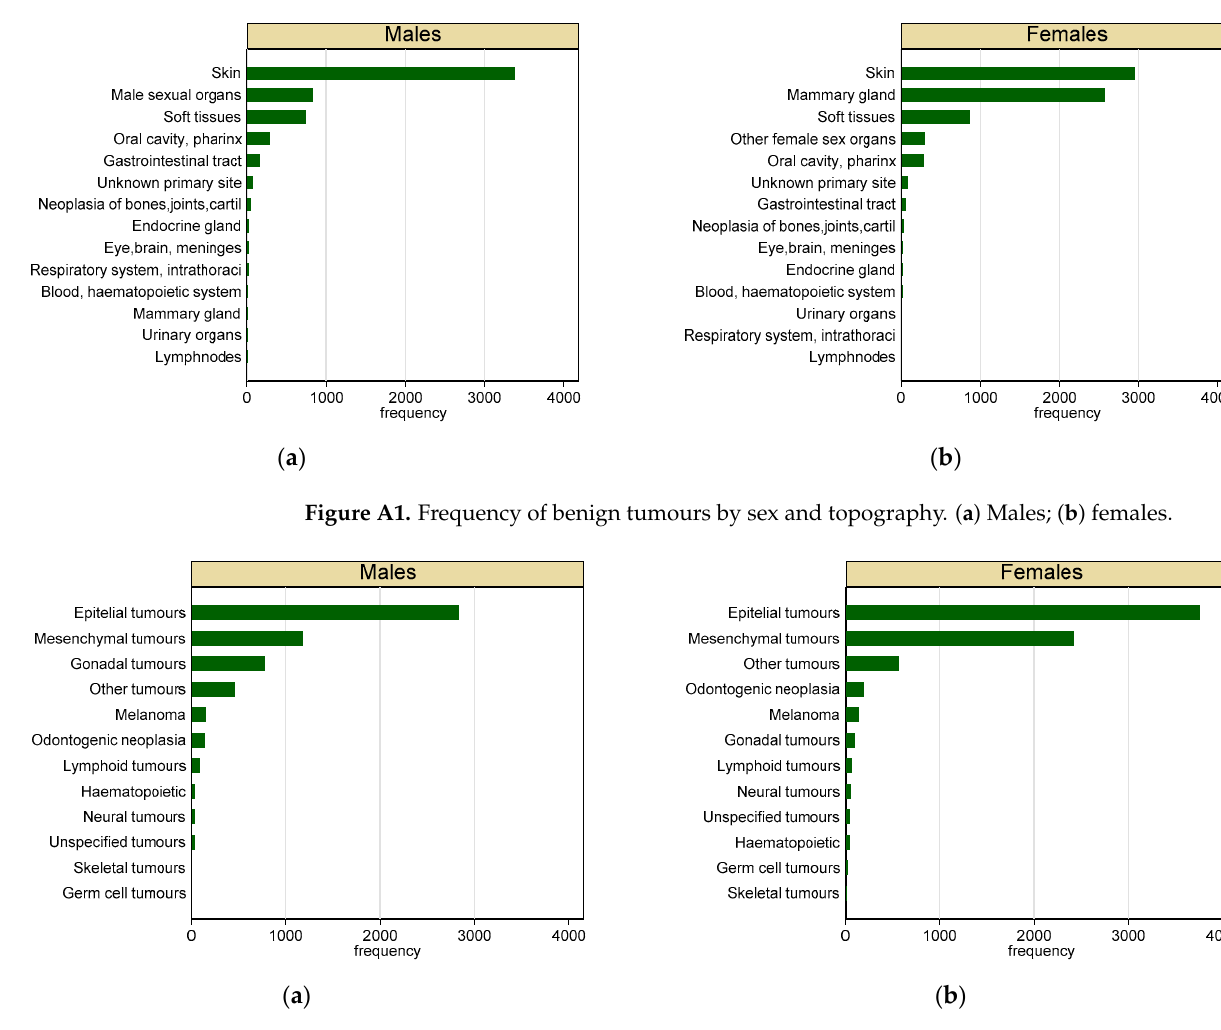
Figure A2. Frequency of benign tumours by sex and histotype. ( a ) Males; ( b ) females.